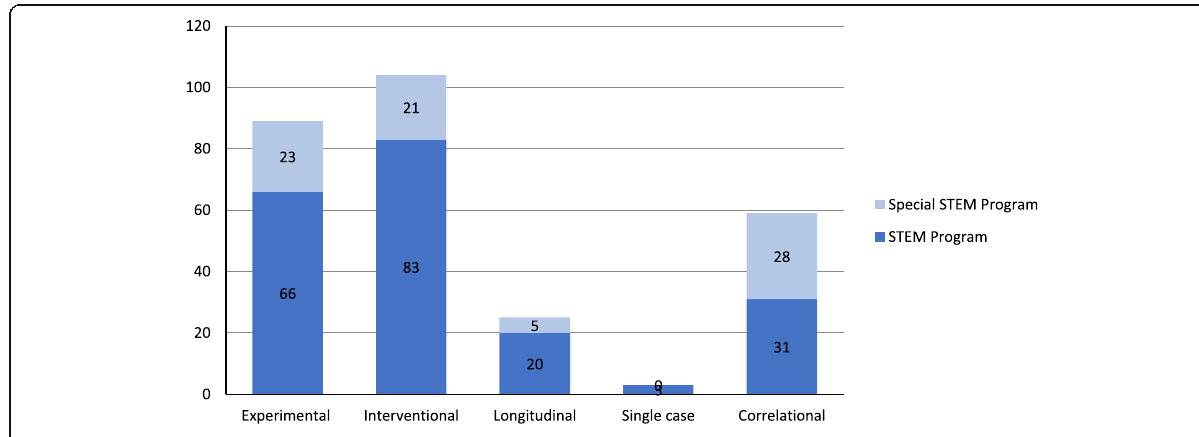
Fig. 20 The number of projects in terms of the type of research